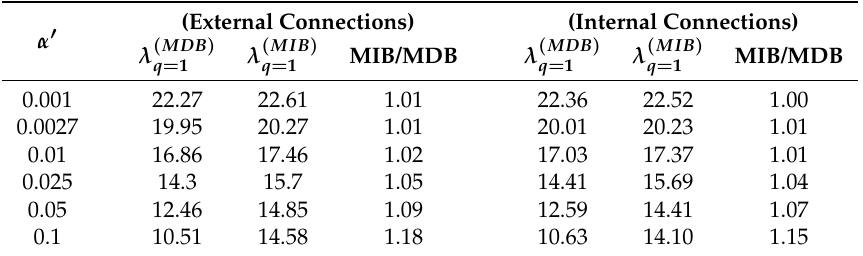
Table 5. Relationship between the MDB and MIB for network ( a ) by considering ˜ P CI = ˜ P CD = 0.8.